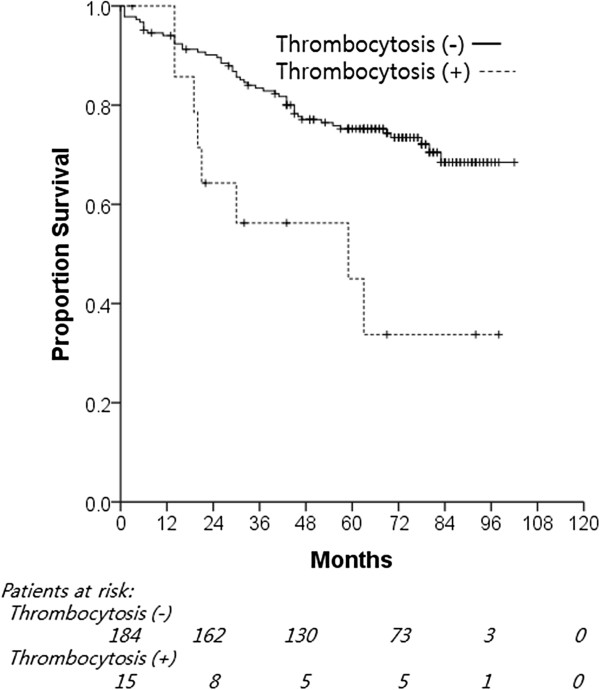
Correlation between preoperative thrombocytosis and overall survival. Kaplan–Meier plots of overall survival of patients with resectable NSCLC according to preoperative thrombocytosis (P = 0.003). NSCLC, non-small cell lung cancer.